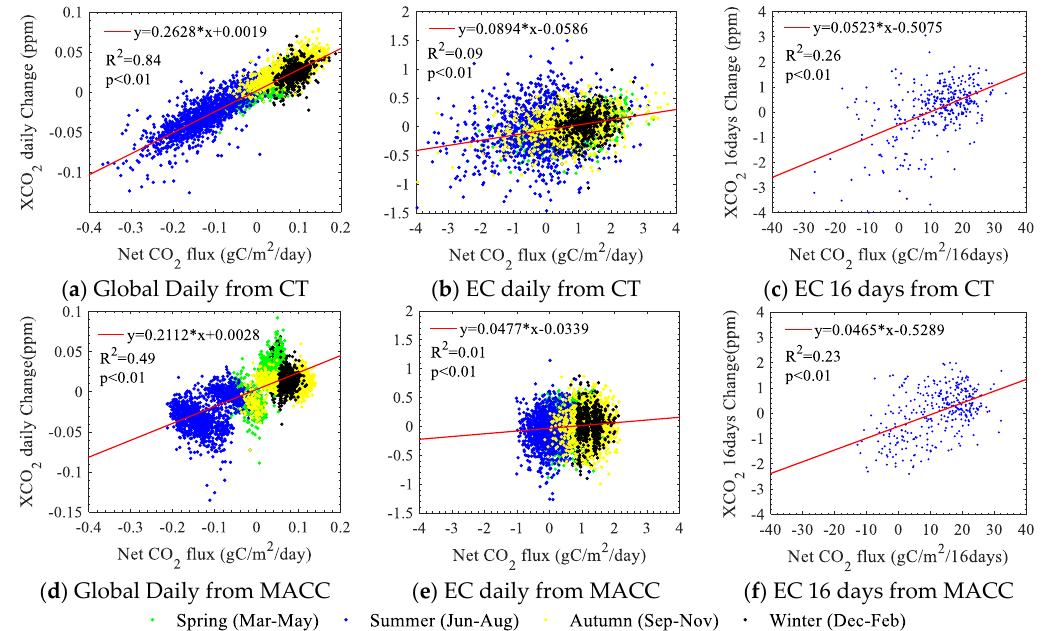
Figure 7. Estimates of the relationship between XCO 2 drawdown and surface CO 2 flux magnitudes. Correlation between daily XCO 2 changes and daily CO 2 flux, from CarbonTracker (CT) and Monitoring Atmospheric Composition and Climate (MACC), for the global mean, ( a ) for CT and ( d ) for MACC, and Eastern China (EC), ( b ) for CT and ( e ) for MACC. Correlation of 16-day changes over EC is shown in ( c ) for CT and ( f ) for MACC. XCO 2 changes are calculated with the XCO 2 from adjacent two days (day 2 or day 16 minus day 1), and CO 2 flux is the mean value of CO 2 flux during day 1 or the whole of 16 days. Different colors in ( a ), ( b ), ( d ), and ( e ) show the CO 2 fluxes and concentrations from different seasons (green for March to May, blue for June to August, yellow for September to November, and black for December to February). In our inferred flux estimates, we adopt the 16-day relationship.